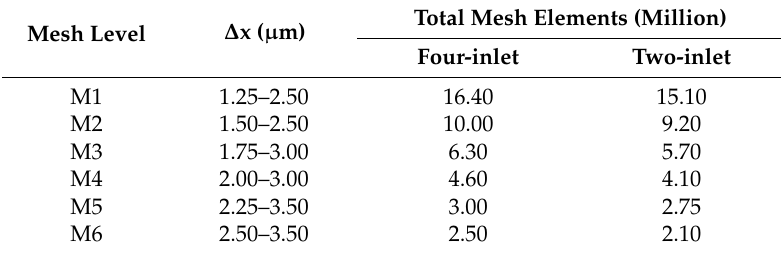
Table 1. Mesh properties and densities for six different levels.